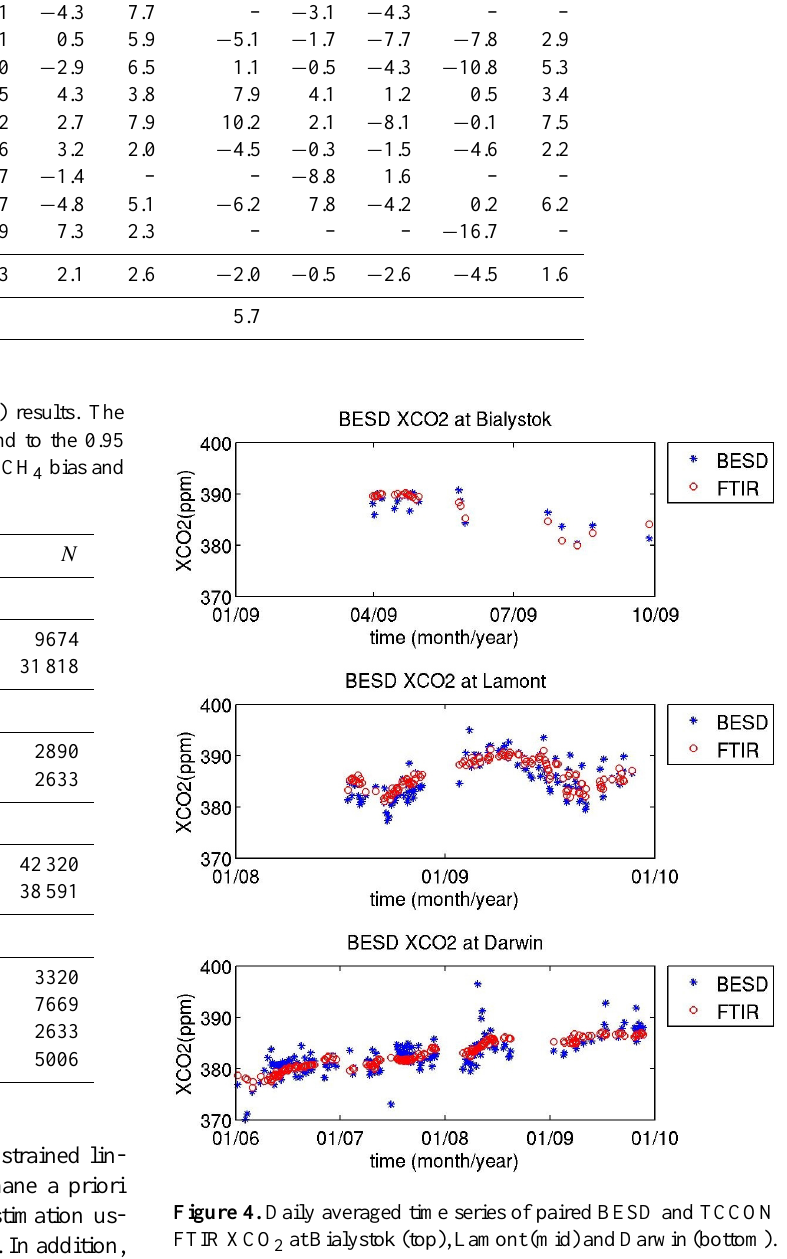
Bad detector Pixel Mask”, or DBPM), while WFMD uses several masks, each one optimized for a certain time